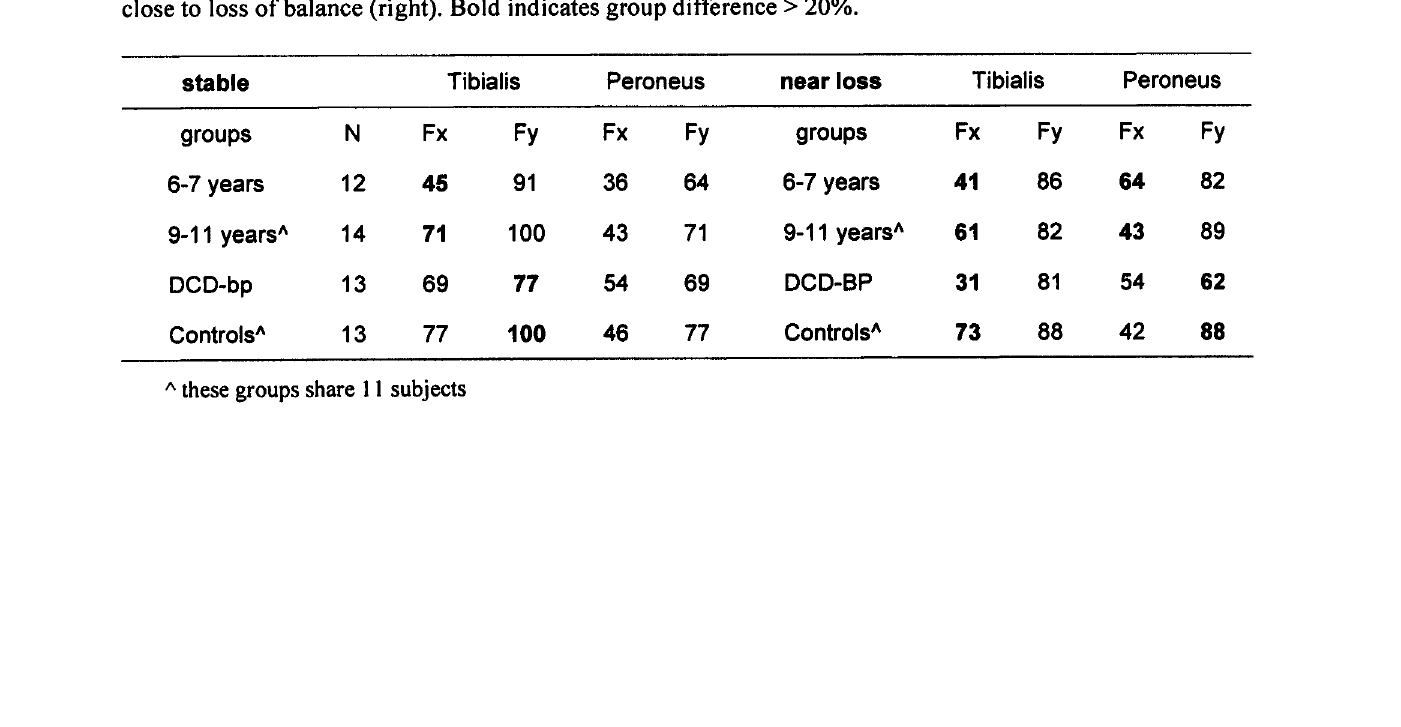
Percentage of subjects with significant (p < 0.01) correlations for the 1.5s epochs of stable balance (left) and close to loss of balance (right). Bold indicates group difference >